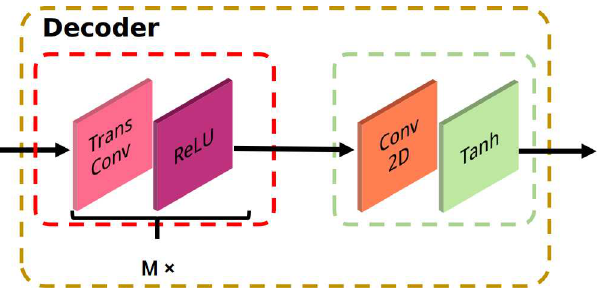
Figure 3. Details of the proposed decoder component. The decoder consists of two parts, including a transposed convolution layer with a ReLU activation function and a convolution with a convolution layer and a Tanh